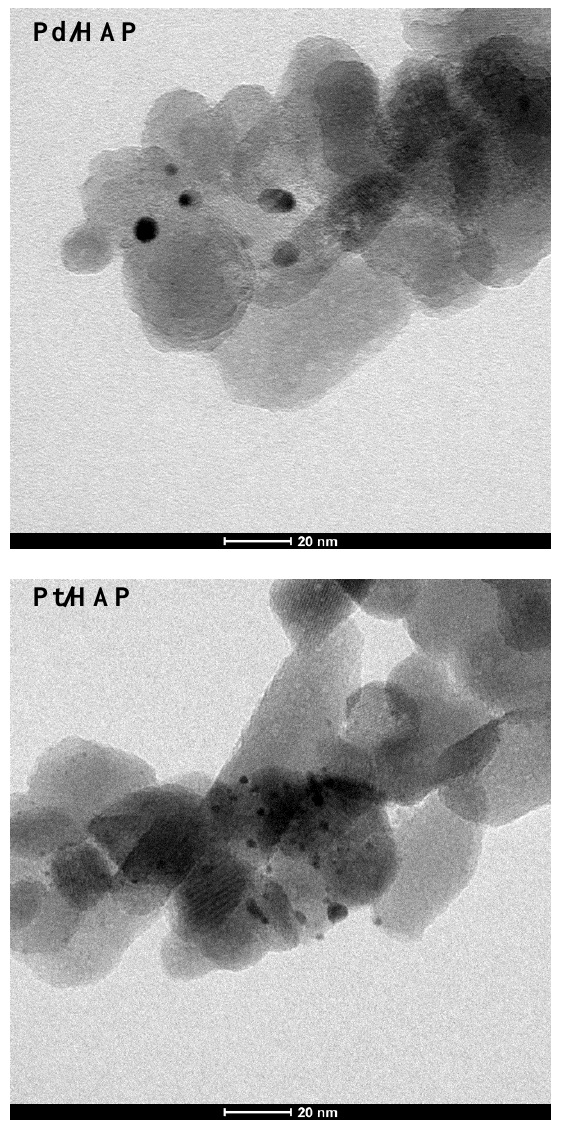
Figure 4. TEM micrographs of the reduced noble metal catalysts. Table 2. CO chemisorption, TEM, and catalytic activity data for the noble metal catalysts.